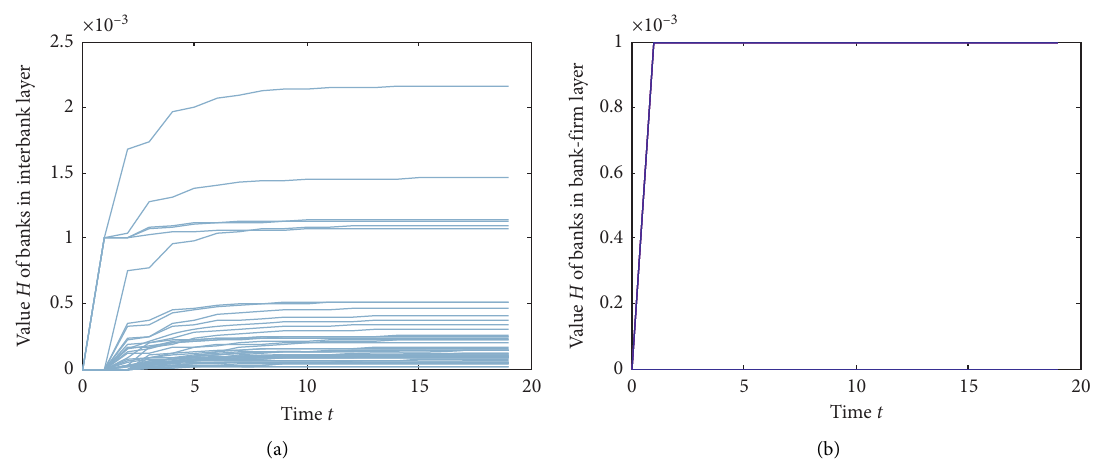
Figure 7: Changes of H values over time in different network layers.